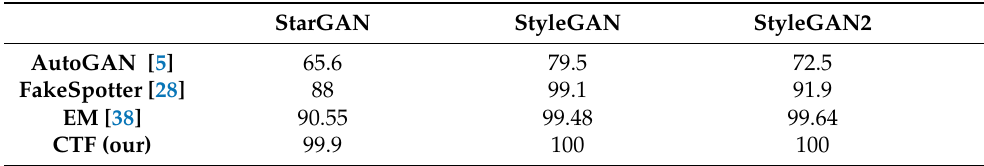
Table 2. Comparison with state-of-the-art methods [5,28,38]. Classification of Real images (CelebA and FFHQ) vs. Deepfake images. Accuracy values (%) of each classification task are